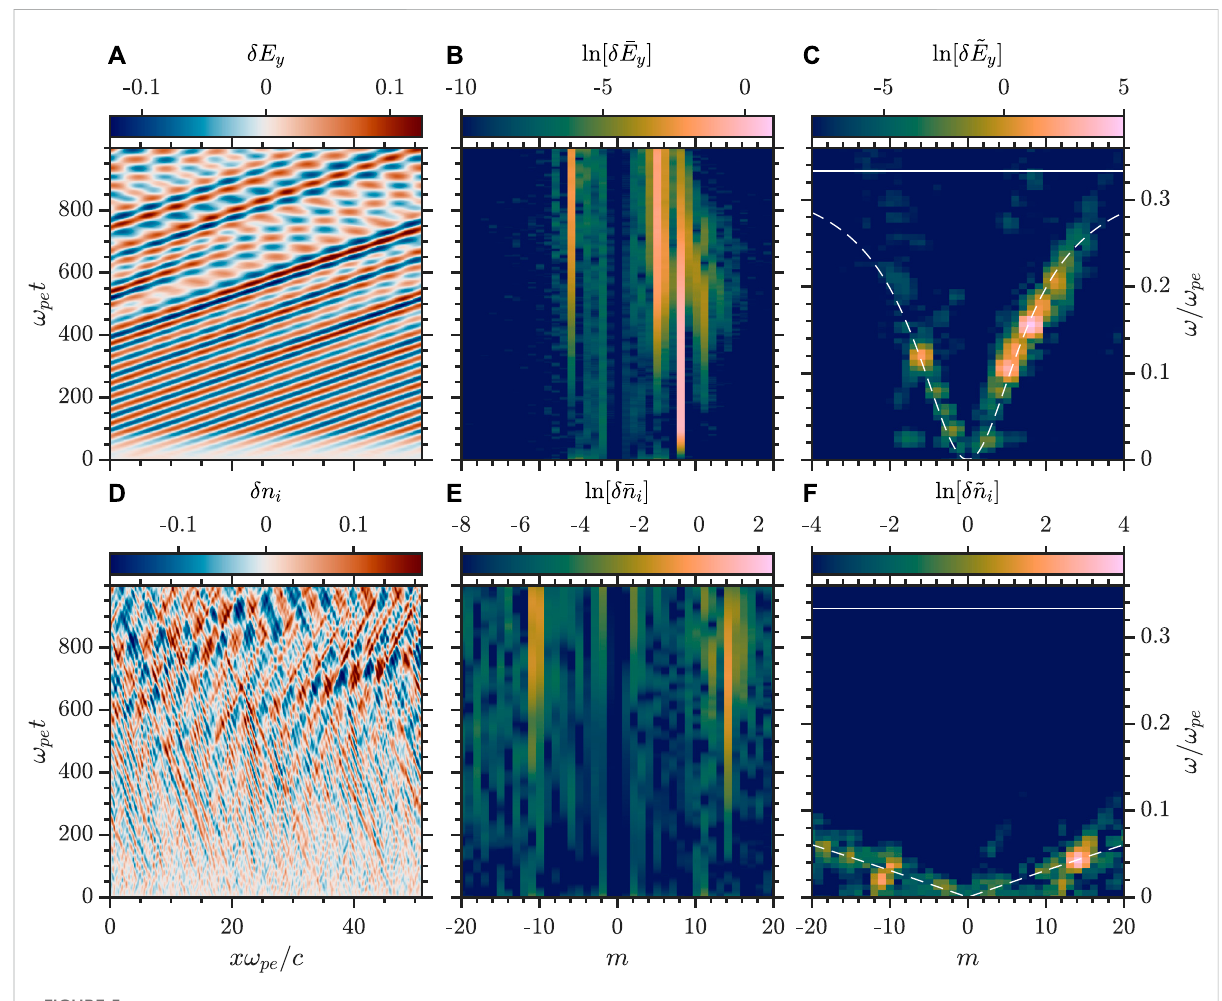
FIGURE 5 Doubleparametricdecayofwhistlerwavewith δ B w / B 0 =0.052 (A) , (B) ,and (C) xt -space, mt -space,and m ω -spaceof δ E y ,respectively (D) , (E) ,and (F) xt -space, mt -space, and m ω -space of δ n i , respectively. Dashed lines indicate the whistler and IAW branches in (C) and (F) , respectively, and the solid line is ω ce / ω pe